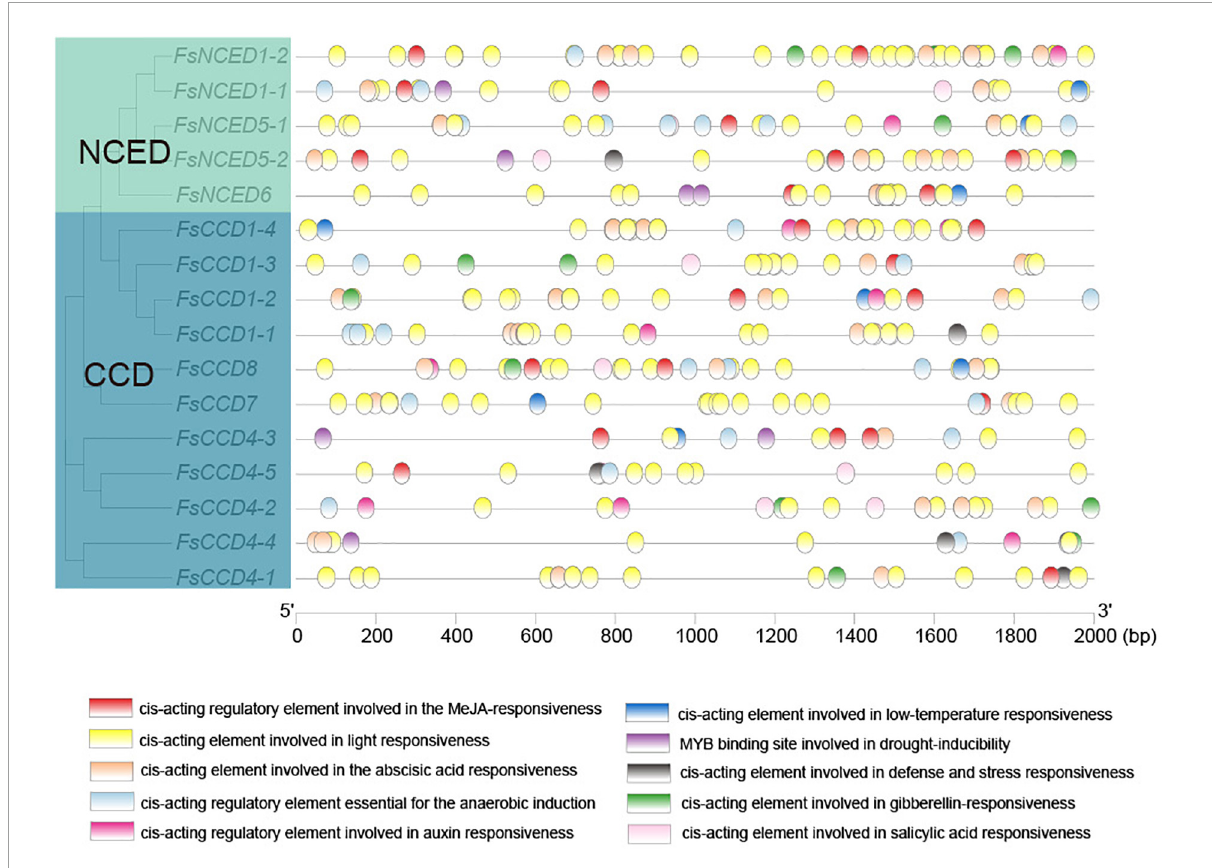
FIGURE6 Cis -acting elements analysis of the promoters of CCD genes of Forsythia suspensa .